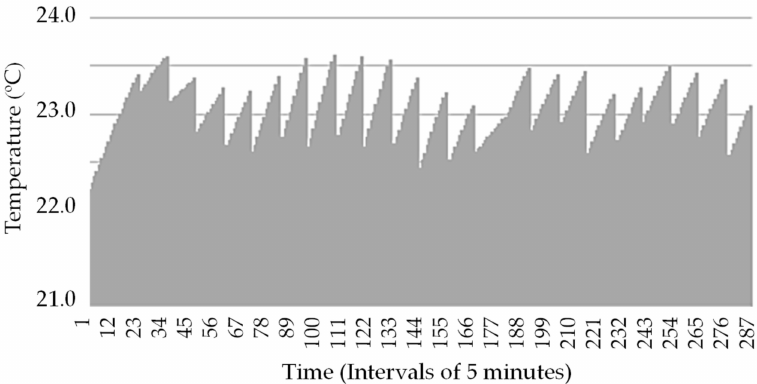
Figure 11. Evolution of the environmental temperature in the smart house, during the day, considering flat price